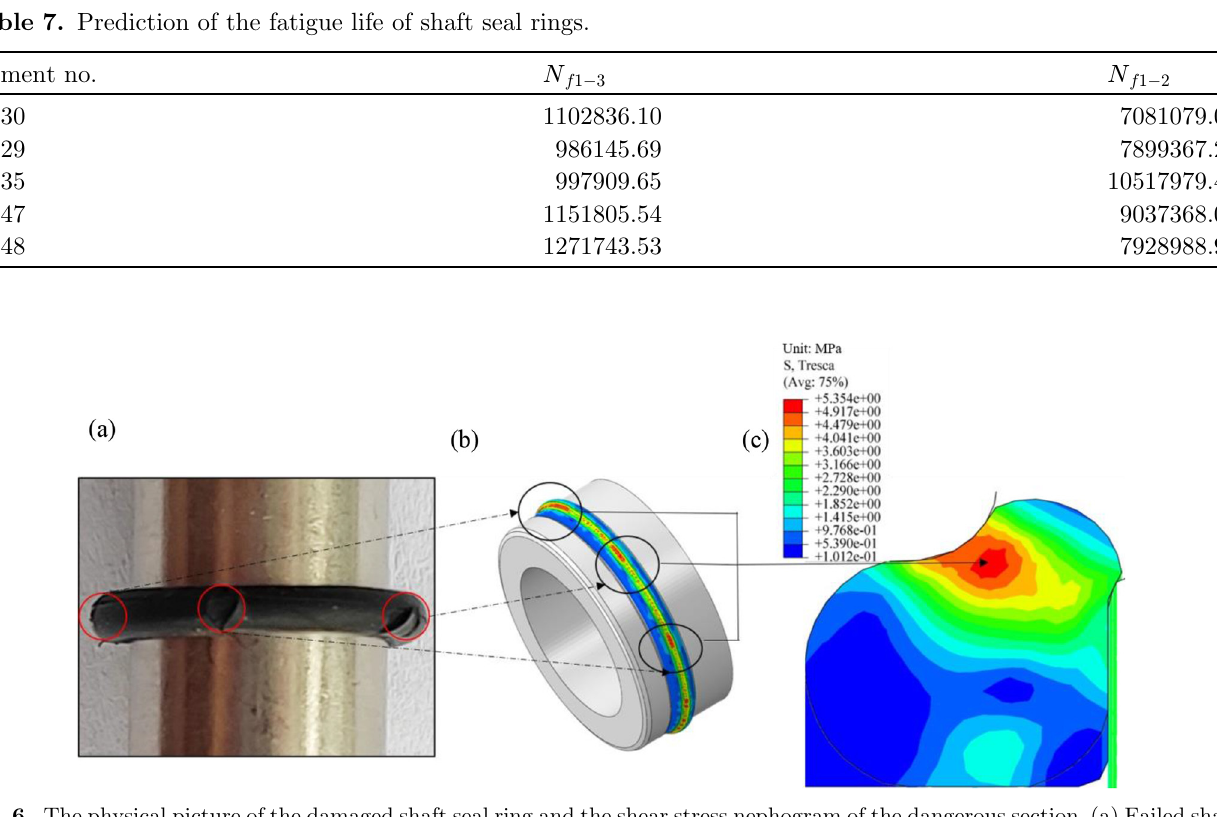
Fig. 6. The physical picture of the damaged shaft seal ring and the shear stress nephogram of the dangerous section. (a) Failed shaft seal ring (b) Simulation shear stress nephogram of assembly process (c) Pro fi le of dangerous section of shaft seal